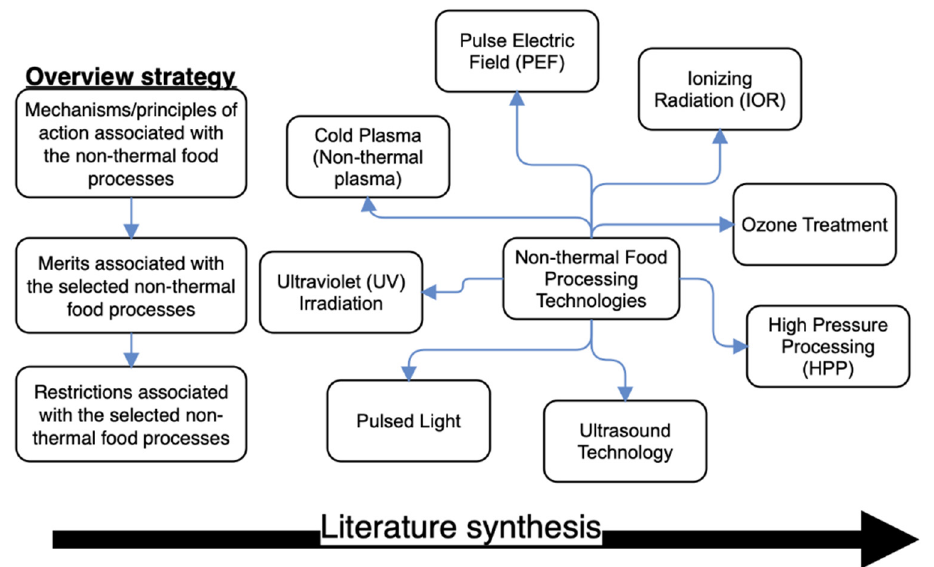
Figure 1. Schematic representation of non-thermal food processing technologies synthesized (which include: pulsed electric field (PEF), pulsed light (PL), ultraviolet radiation (UV), ionizing irradiation (IOR), high-pressure processing (HPP), ozone treatment, cold plasma (non-thermal plasma), and ultrasound technology) with the overview strategy (which include: mechanisms/principles of action, and the associated merits, and restrictions).